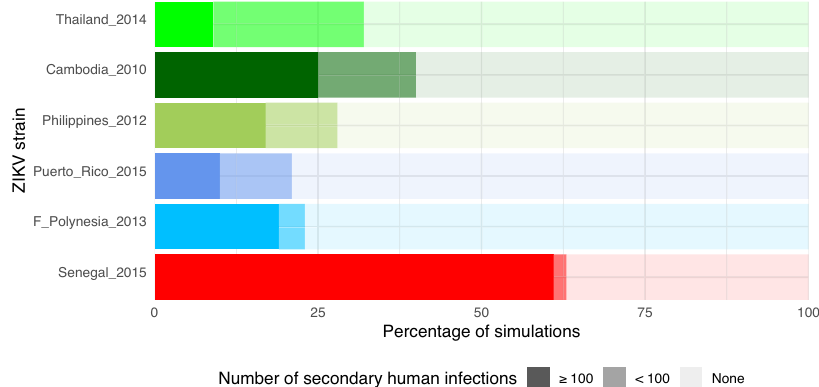
Fig. 3 Simulated effect of empirical variation in ZIKV transmissibility on the risk and magnitude of human outbreaks. A stochastic agent-based model was run 100 times based on the experimentally determined kinetics of mosquito transmission of six ZIKV strains. Other parameters of the model, such as the mosquito biting rate and infection dynamics within the human host, were shared between viruses. The fi gure shows the proportion of simulated outbreaks that resulted in ≥ 100, <100, and no secondary human African ZIKV strains are more lethal than Asian strains in (Fig. S1) resulted in reduced epidemic potential for all ZIKV immunocompromised adult mice . To assess the ability of ZIKV strains (Fig. S2). Together, the simulation results indicate that the higher transmissibility of the African ZIKV strains in our strains to cause more or less severe disease in a mammalian laboratory experiments translates into a markedly higher model, we inoculated AG129 mice with 10 3 plaque-forming units (PFU) of ZIKV and monitored their viremia, body weight, and probability and size of human outbreaks predicted by our clinical signs of disease. Viremia levels ranged from 4.71 to 9.15 epidemiological model.